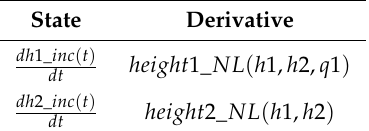
Table 2. Differential equations of original system (nonlinear